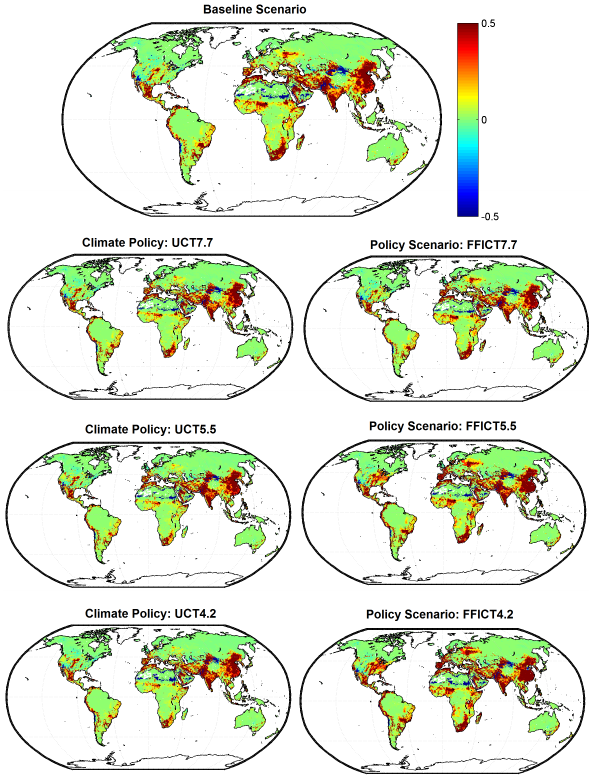
Figure 11: GCAM’s downscaled water scarcity results in year 2095 under each of the climate Figure 11. GCAM’s downscaled water scarcity results in the year policies. 2095 under each of the climate policies. Figure 12: Changes in water scarcity conditions from 2005 to 2095 different climate change Figure 12. Changes in water scarcity conditions from 2005 to 2095 mitigation policies; positive values (red) denote increased scarcity conditions in 2095 as reflecting different climate change mitigation policies; positive val- compared to 2005 ues (red) denote increased scarcity conditions in 2095 as compared to 2005.